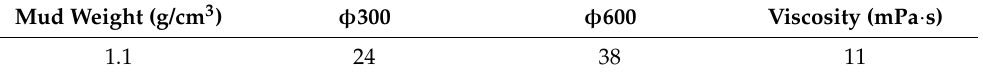
Table 4. Drilling fluid performance for well L.